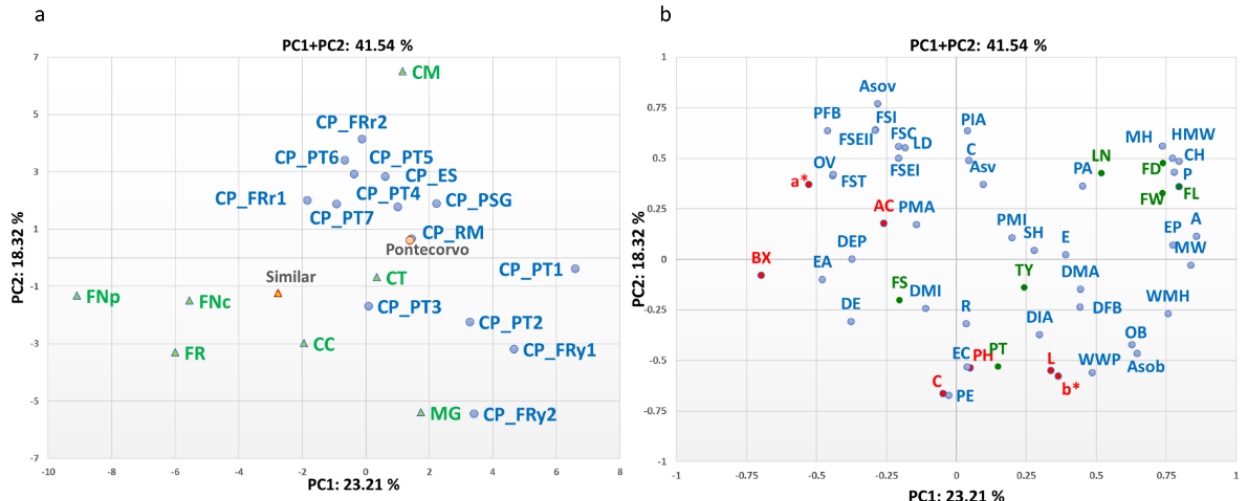
Figure 2. Loading plot of the first (PC1) and second (PC2) principal components showing the variation in 52 morpho-agronomic traits scored for 21 accessions. ( a ) ‘Peperone Cornetto di Pontecorvo’ (Pontecorvo) and similar types are indicated with different coloured symbols; the first and second component centroids for each cultivar groups are indicated by filled yellow symbols with shape and edge colour according to cultivar group. ( b ) On the right are indicated the distribution of the traits scored. The direction and distance from the centre of the biplot indicates how each OTU contributes to the first two components. The different categories of traits are indicated using different colour codes as follows: agronomic traits in green, chemical traits in red, digital morpho traits in blue. Trait acronyms are listed in Tables 3 and 4.